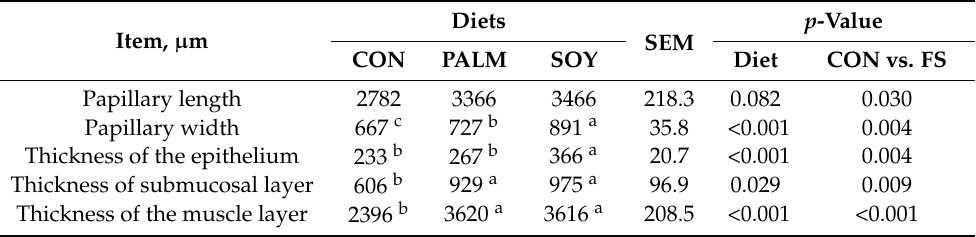
Table 7. Morphological characteristics of the ruminal papilla of lambs fed diets with fat supplements of (FS; 50 g/kg) prilled palm oil (PALM), soybean oil (SOY), or without fat supplementation